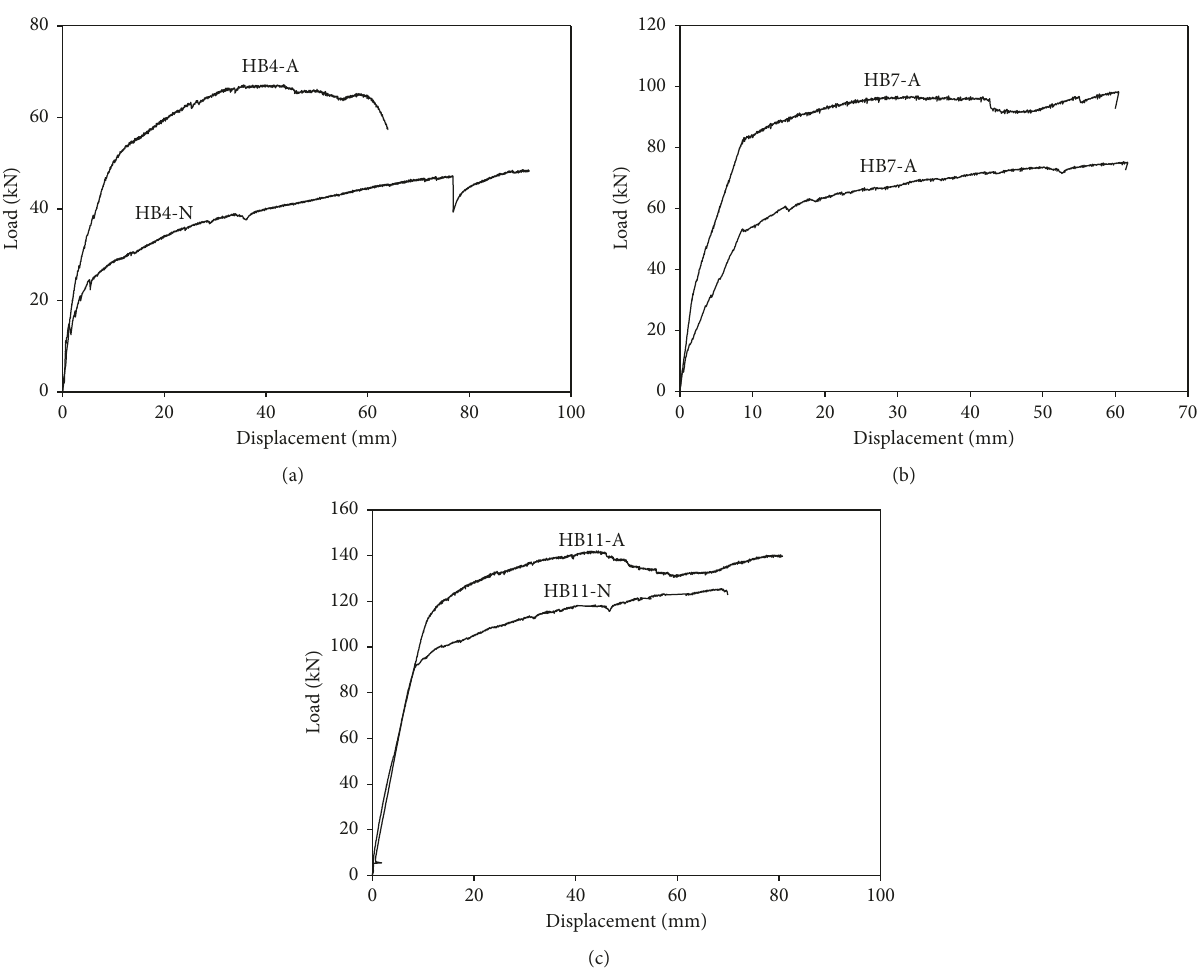
Figure 14: Load-displacement curves of UHPC flexural